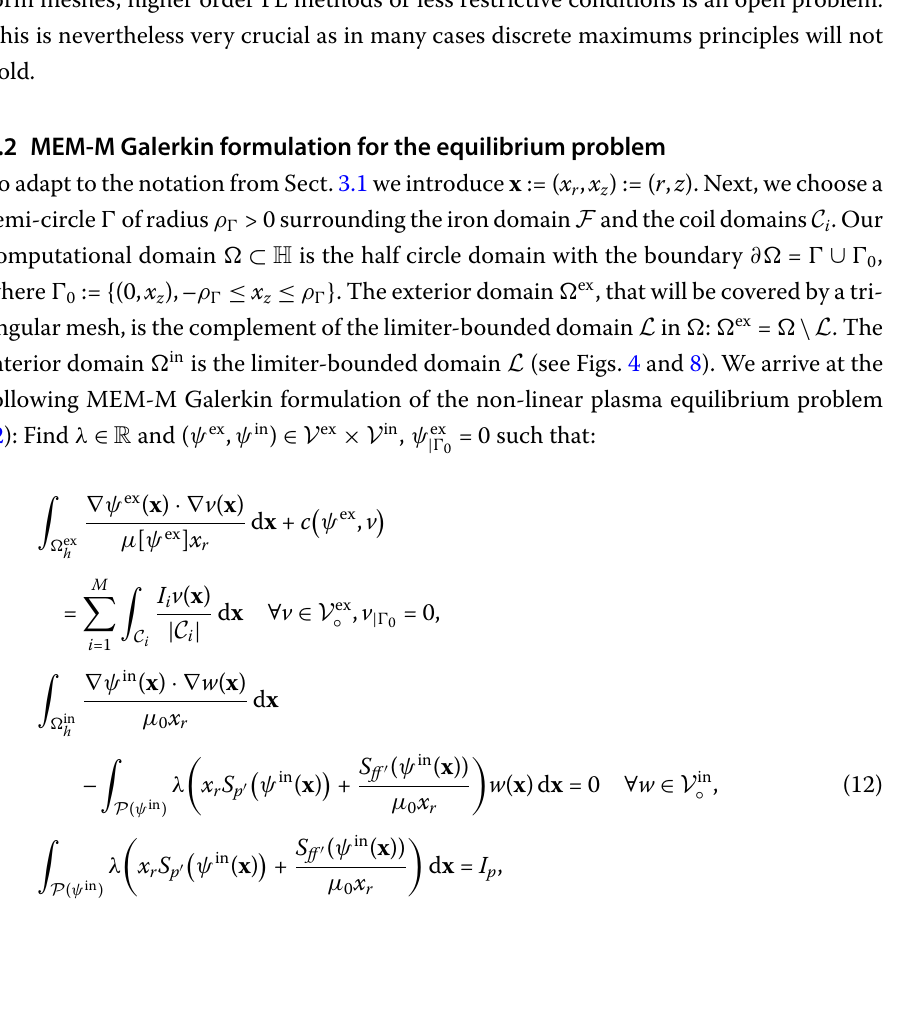
(left), that is h has a large h